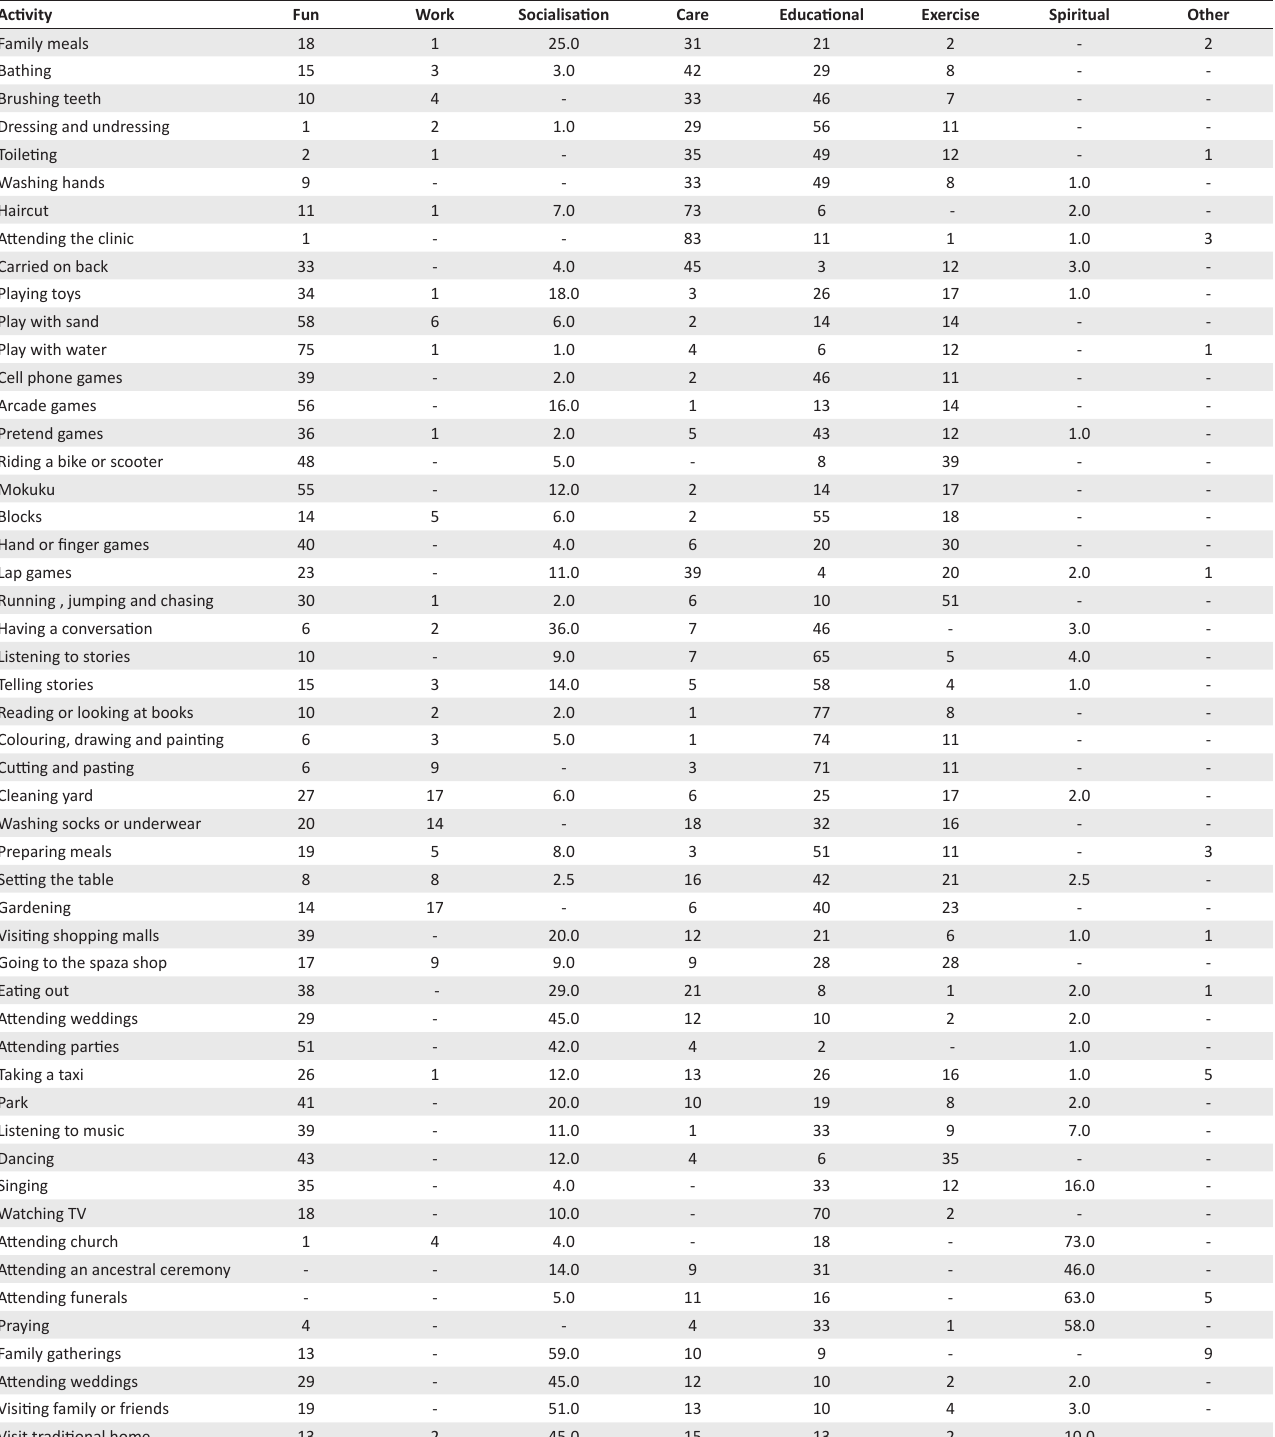
TABLE 3: Caregivers perceptions about the purpose of activities ( N = 90). Activity